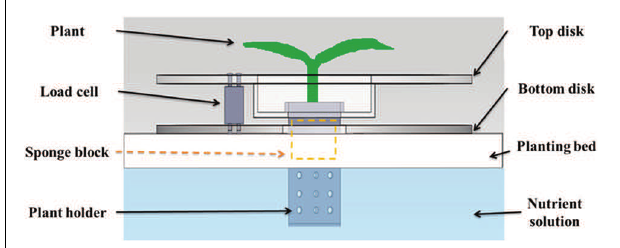
FIGURE 1 | The design of weight measurement